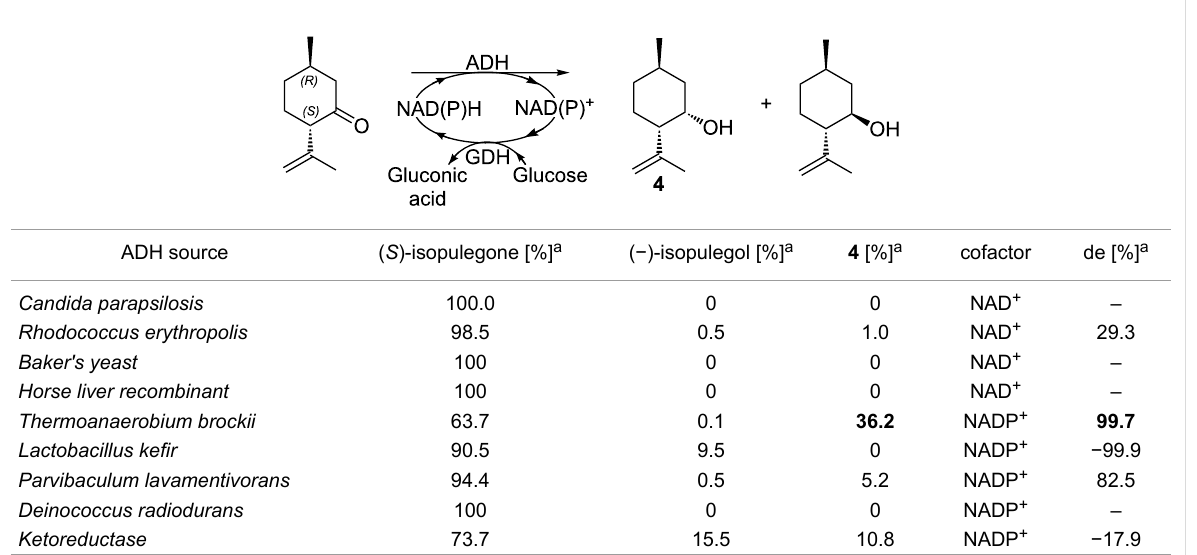
Table 1: Alcohol dehydrogenase screening results, method